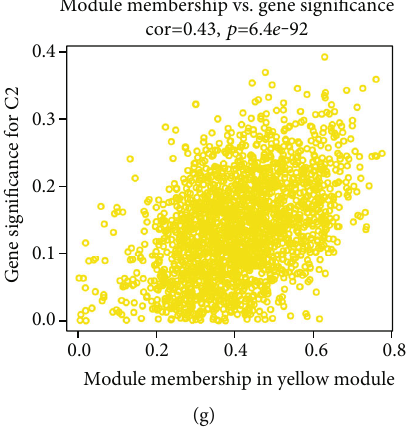
Figure 4: The hub gene in the RNAseq data set was identi fi ed by WGCNA. (a) Clustering trees of every sample. (b) Scale-free exponential analysis on soft threshold powers (STP, β ). (c) The average connectivity between di ff erent STPs was analyzed. (d) The dendrogram was constructed using DEGs based on di ff erent degrees of measurement clustering (1-TOM). The di ff erent colored bands indicated the results of automatic block analysis. (e) Statistics of gene no. in each module. (f) The relationship between the module feature vector of every module and clinical data. (g) Scatter diagram that plots the MM vs. GS values for C1 in the yellow